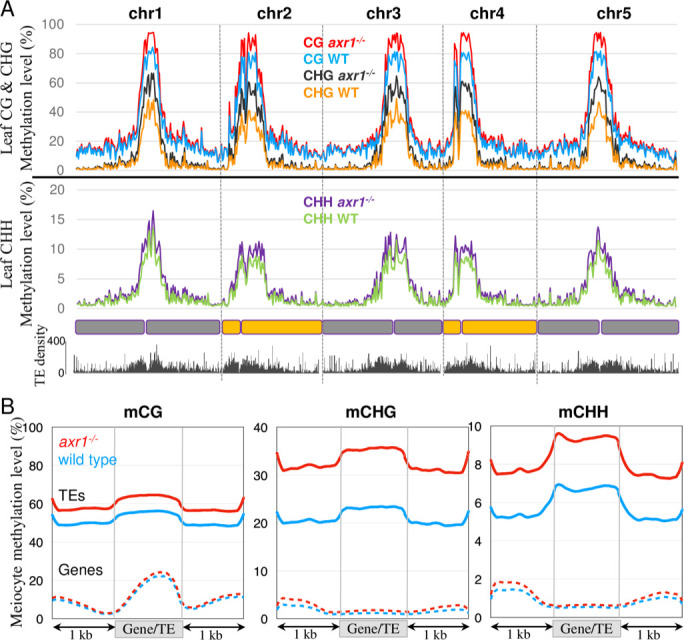
Patterns of DNA methylation in somatic cells.A: Methylation along chromosomes, calculated from non-overlapping 200 kb bins. The average methylation levels were determined by combining the biological replicates for each genotype. B: Patterns of methylation in genes and TEs in the Col-0 wild type (blue lines) and the axr1-/- mutant (red lines). The average methylation level of genes and TEs was determined by dividing the corresponding annotated regions into 100 bp bins. Regions located 1 kb upstream and 1 kb downstream of the gene bodies or TEs are shown. The average methylation levels were determined by combining the biological replicates for each genotype.